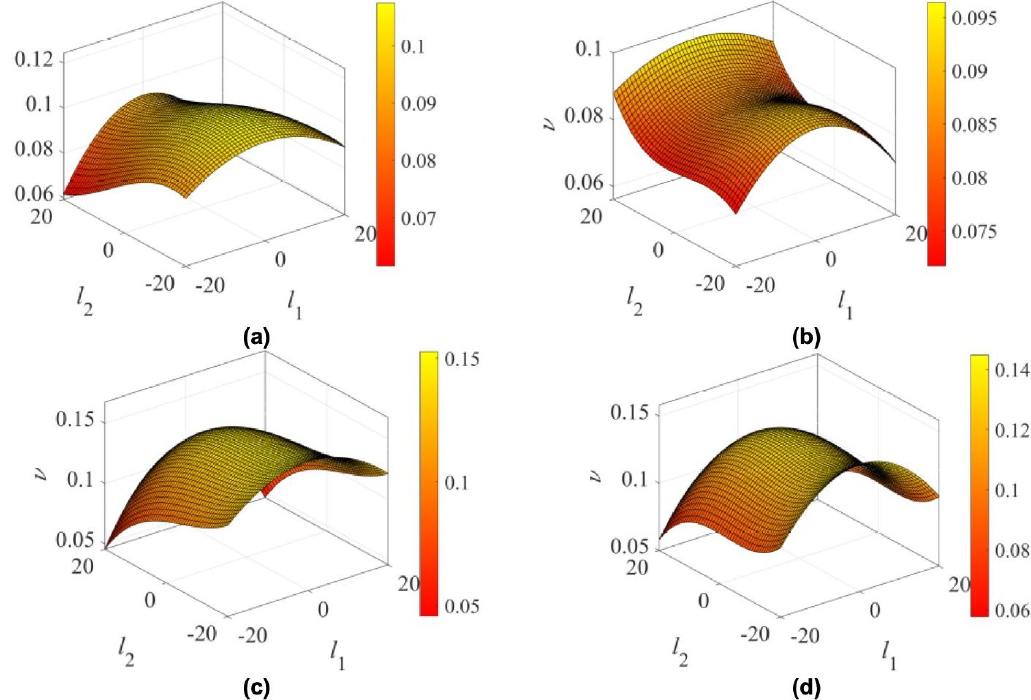
Figure 10: Pressure mode #1 for rectangular plan with θ = 0 ∘ and geometry G 5 (a), G 6 (c), G 7 (b), G 8 (d), referring to Table 1